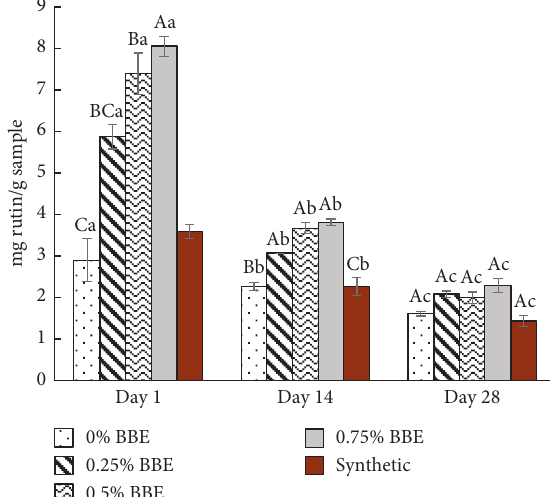
Figure 2: The total flavonoid content (mg rutin/g sample) of fish sausage samples fortified with 0%, 0.25%, and 0.5% BBE and synthetic additive BHT. Values of means ± standard deviation (SD) of triplicate independent experiments. Different capital letters indicate significant differences ( p < 0 . 05) within the samples in same day. Different small letters indicate significant differences ( p < 0 . 05) of the same sample across the storage days 1, 14, and 28 at 4 ° C.